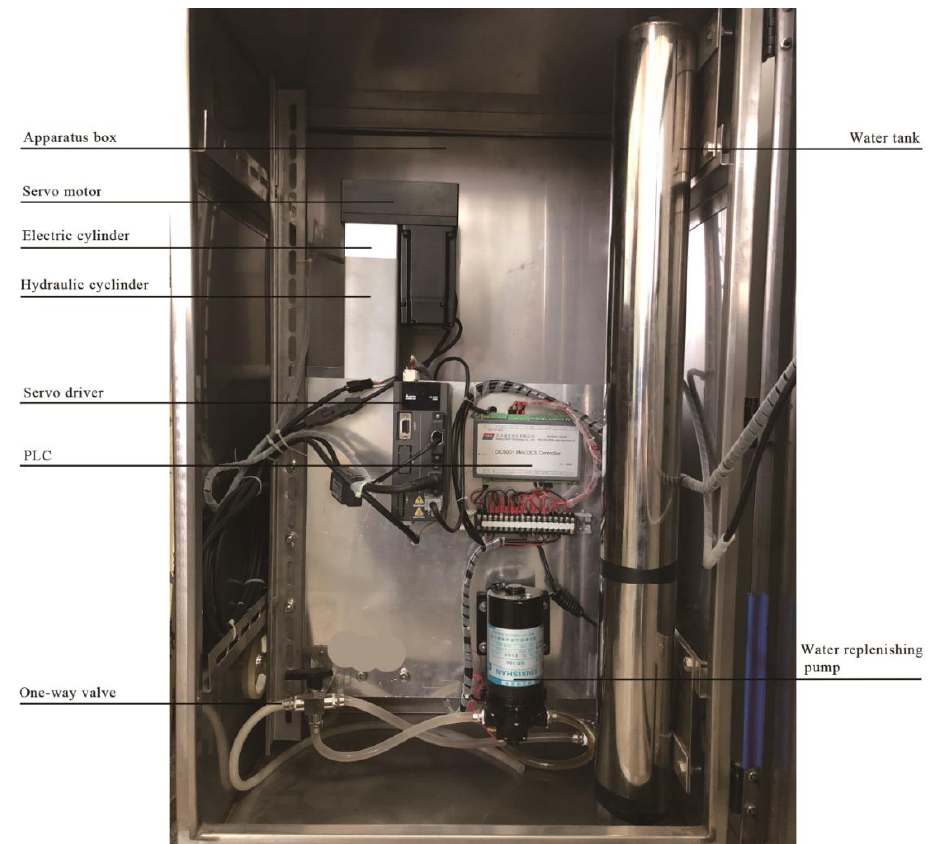
Figure 2. Physical picture of the seepage apparatus.